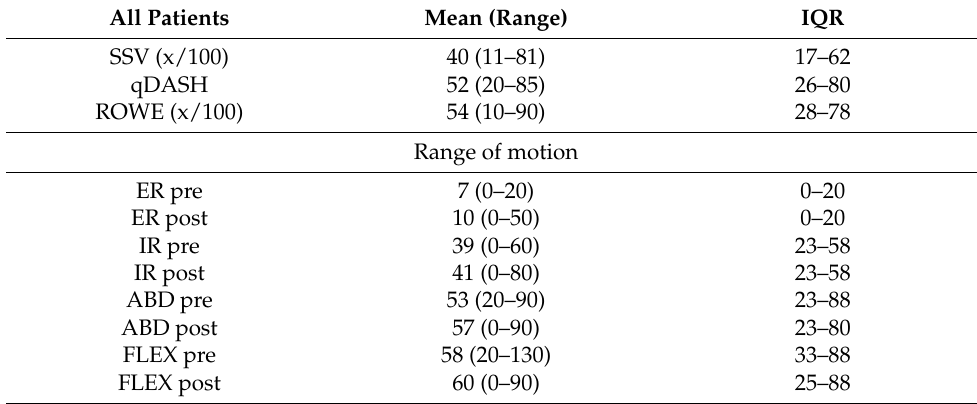
Table 4. Postoperative scores after second step of prosthesis reimplantation and range of motion (ROM) prior to prosthesis explantation (pre) and after second step of prosthesis reimplantation (post) of all patients. IQR: interquartile range, ER: external rotation, IR: internal rotation, ABD: